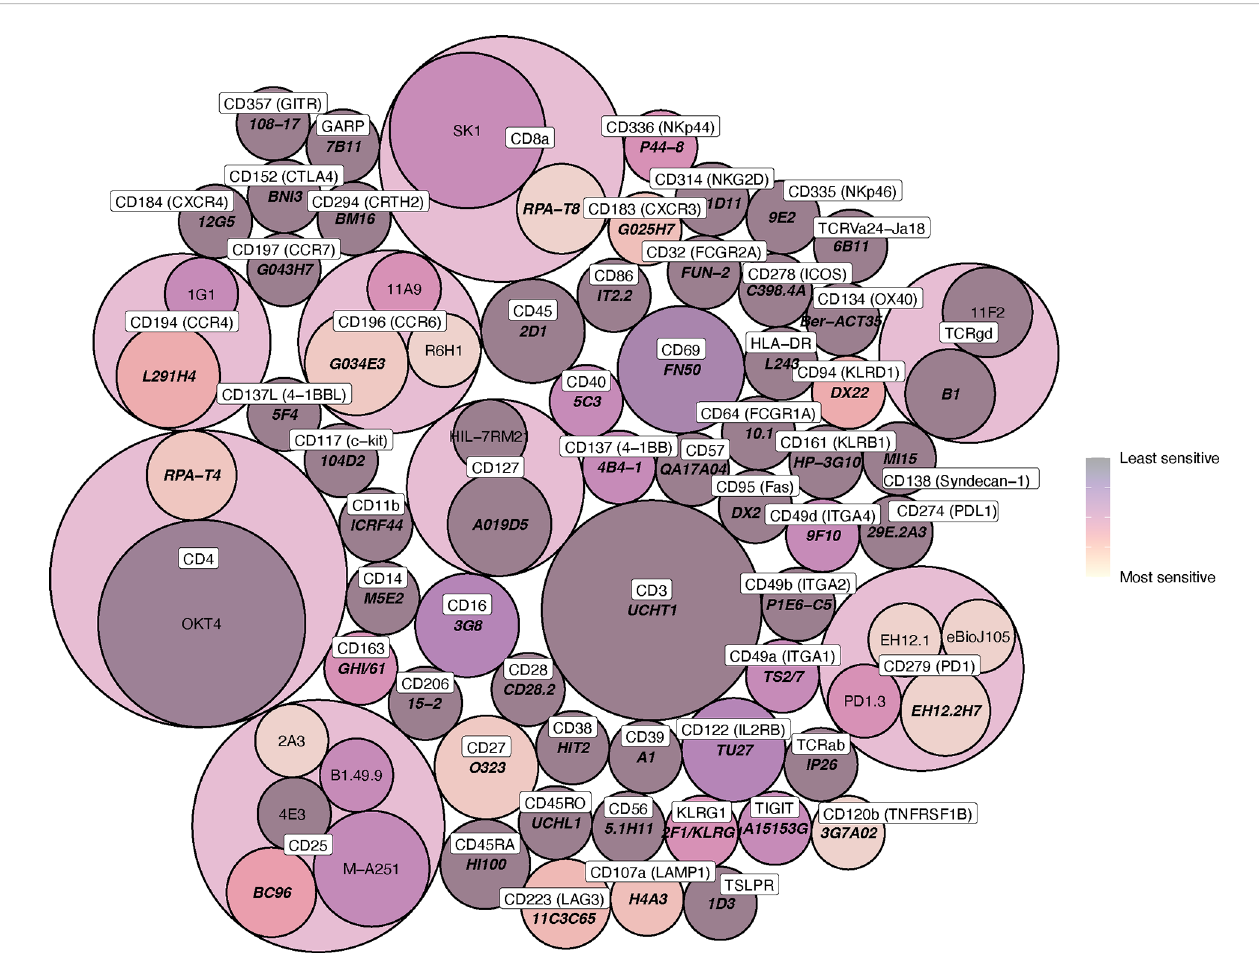
FIGURE 4 Circle packing heat map of clone sensitivity to digestive enzymes. The colour scale indicates relative proportion of replicates sensitive or partially sensitive to digestion, and the size of each circle indicates the number of replicates included in analysis. Circle containers indicate successive levels of hierarchy, where clones are grouped according to immune marker (the colour of these encapsulating hierarchy circles, which contain multiple daughter clones, is not indicative of daughter clone